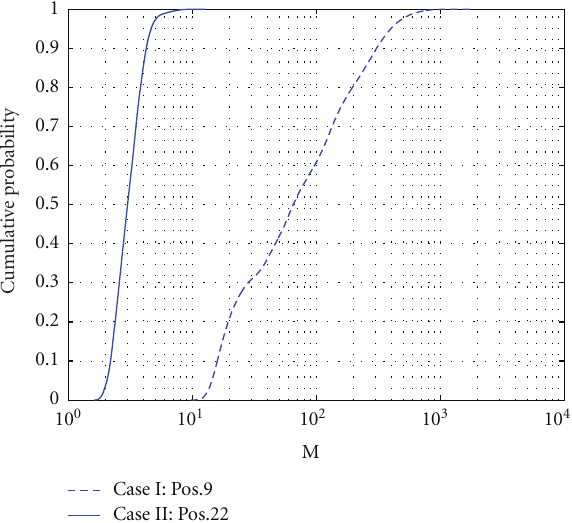
Figure 3: Cumulative probability of M in two considered cases.